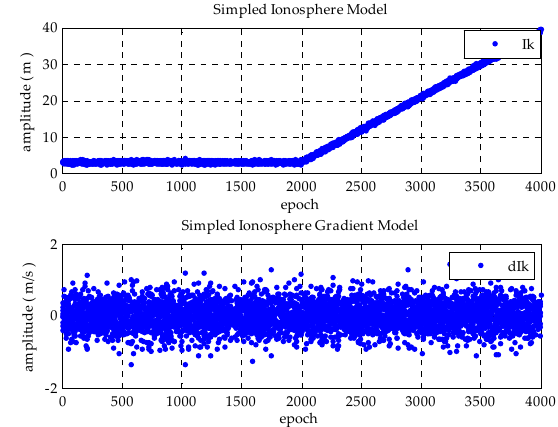
Figure 3. Simulation of the sample ionospheric and ionospheric gradient model in the respective ionospheric gradient-free and ionospheric gradient anomaly cases.